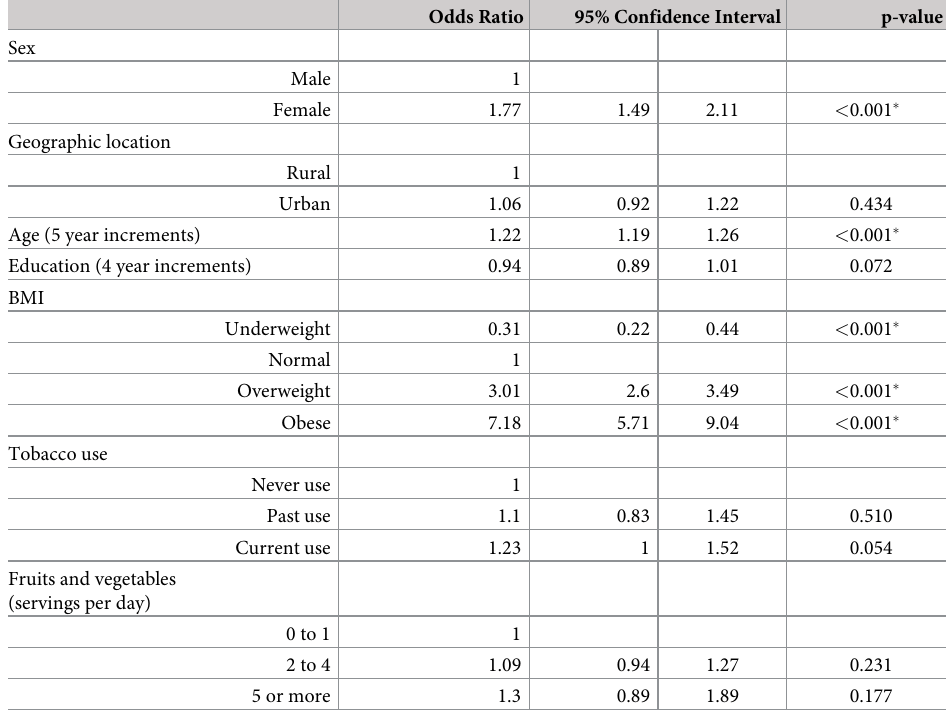
Table 6. Risk factors associated with ATP III metabolic syndrome in a multivariate logistic regression